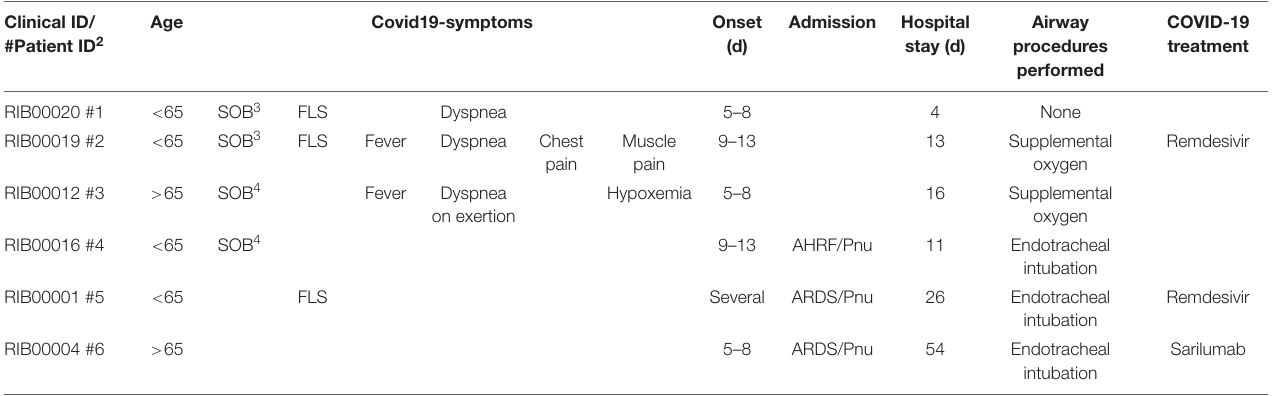
TABLE 1 | Clinical characteristics of Sars-Cov-2 patients 1 .